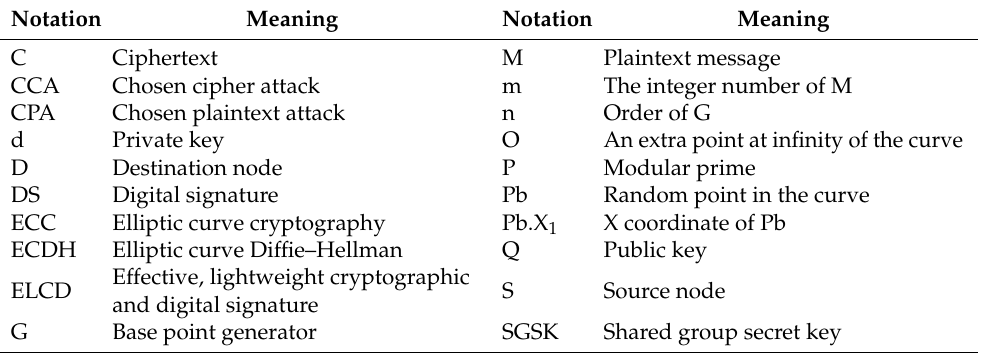
Table 1. Frequently used